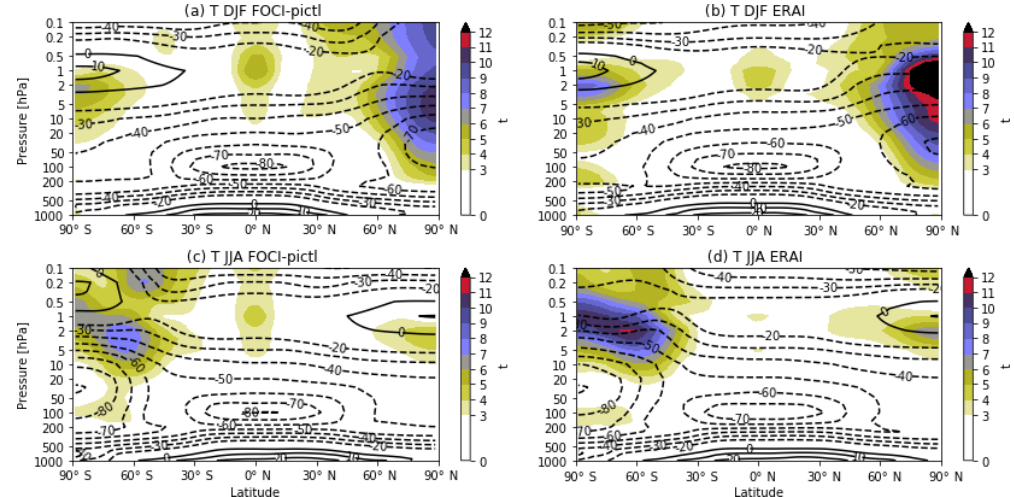
Figure 6. Zonal mean temperature climatology from FOCI-piCtl for (a) DJF and (c) JJA, and ERA-Interim reanalysis climatology (1979 to 2017) for (b) DJF and (d) JJA; contour interval is 10 ◦ C; shading indicates the standard deviation of zonal mean temperature in ◦